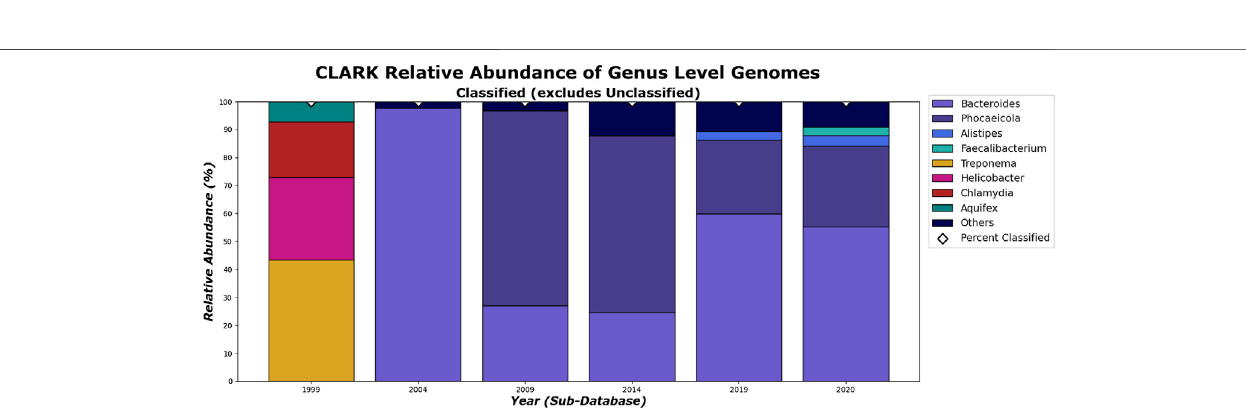
Frontiers in Signal Processing |